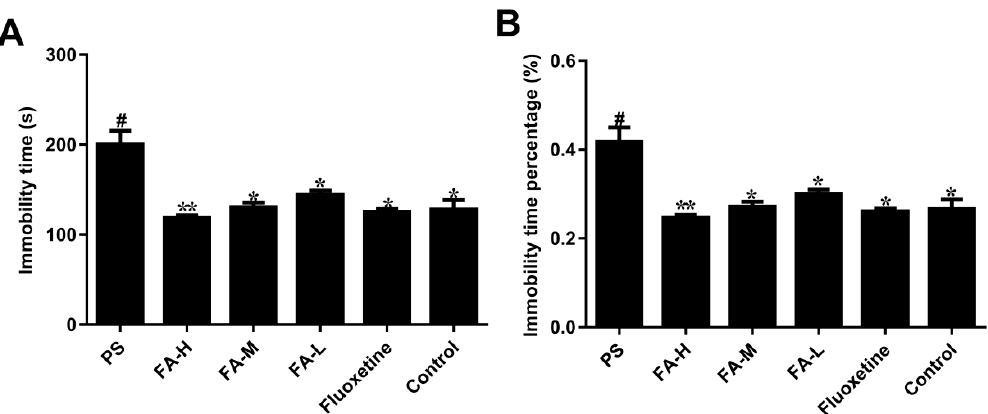
Figure 2. Effects of ferulic acid (FA) on the forced swimming test of offspring rats exposed to prenatal stress. ( A ) Immobility time in forced swimming test. ( B ) Immobility time percentage in forced swimming test. Values represent means ± SEM ( n = 8). * p < 0.05 and ** p < 0.01 compared with PS group, # p < 0.05 compared with Control group. FA-L: FA at low 12.5 mg/kg/day, FA-M: FA at medium 25 mg/kg/day, FA-H: FA at high 50 mg/kg/day.